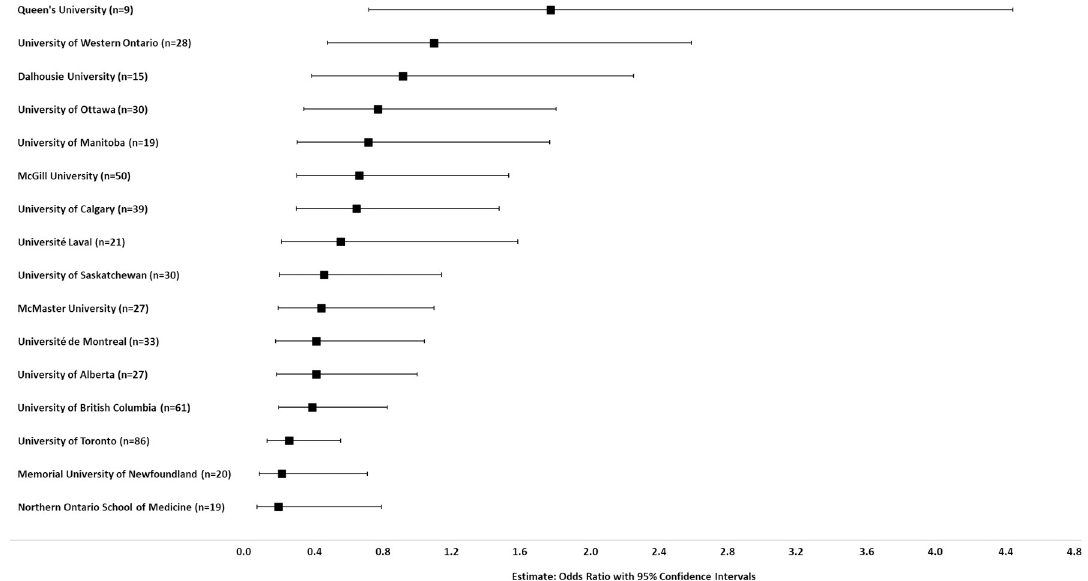
Fig 6. Prediction modeling of the impact of university affiliation on likelihood of women academic surgeons attaining highest levels of leadership (Department, Division or Section Head). Controlled for specialty and higher degrees. Odds ratio with 95% confidence interval graphed for each university compared to the reference university (Universite´ de Sherbrooke, 0.17, highest proportion of women at the highest levels of leadership).